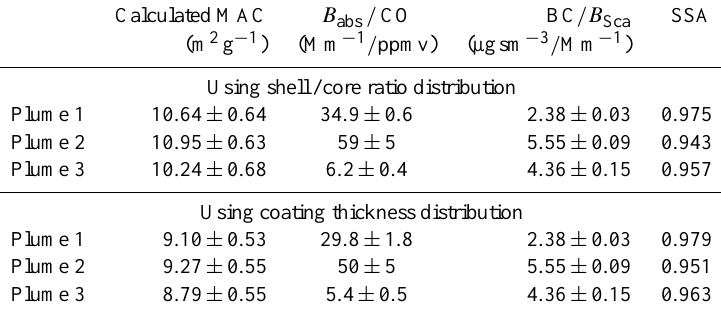
Table 3. BC optical properties (at 532nm) in the three plumes. BC / B Sca ratios are the slopes from Fig. 3c, calculated using orthogonal distance regression fits with zero offset. The listed errors are the fit errors. MAC was calculated using the measured BC core size and coating distributions, integrated over the entire BC size distribution, assuming either a constant distribution of shell/core ratio or absolute coating thickness from Fig. 6. The stated values were calculated using BC core and coating refractive indices n core = ( 1 . 85 − 0 . 71 i) and n coat = ( 1 . 50 − 0 i) . B abs / CO and errors are the standard deviation of the corresponding range in Table S2. SSA values were calculated by combining the calculated MAC with measured BC / CO and BC / B Sca